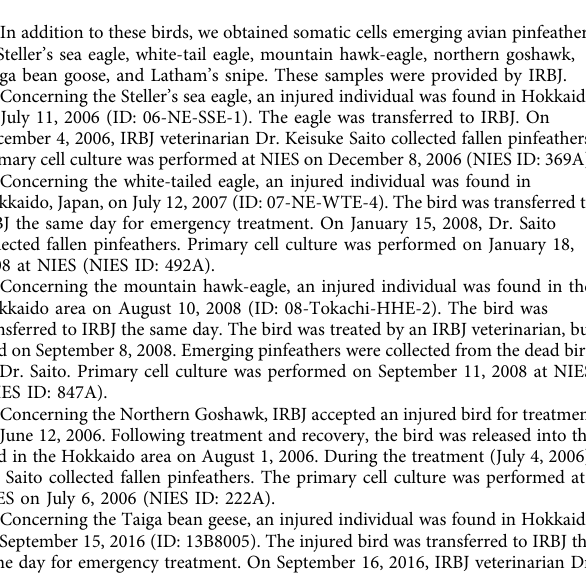
Fig. 8 Contribution of Japanese ptarmigan-derived iPSCs to chicken embryos. a iPSCs were injected into chicken blastoderm after fl uorescently labeling them with a cell tracer. b Interspeci fi c blastoderm was generated after the injection of Japanese ptarmigan-derived iPSCs into chicken blastoderm. Images shows embryos that were not injected (i – iv) and iPSC-injected blastoderm (v – viii). Panels show the merged bright fi eld and green fl uorescence images (i, v), bright fi eld images (ii, v), green fl uorescence (iii, vii), and red fl uorescence (iv, viii). Bars represent 2 mm. c The images show the contribution of iPSCs to the chicken embryo post-injection after 72 h. Arrows indicate green signals. Panels show embryos with no injection (i – iv), and iPSC-injected blastoderm (v – viii). Panels show merged bright fi eld and green fl uorescence images (i, v), bright fi elds (ii, vi), green fl uorescence (iii, vii), and red fl uorescence (iv, viii). Bars represent 2 mm. d Reaction of anti-hygromycin antibody with Japanese ptarmigan iPSCs. Staining images of the anti-hygromycin antibody with red fl uorescence-labeled secondary antibody (i – iii), staining images of the anti-hygromycin antibody with green fl uorescence-labeled secondary antibody (iv – vi). Panels show merged images (i, iv), green fl uorescence (ii, v), and red fl uorescence (iii, vi). Scale bar represents 50 μ m. e Detection of GFP, hygromycin resistance gene, and DAPI signals in embryonic cryosections on day 5. Panels show the merged image (i, v), the GFP (ii, vi), the hygromycin resistance gene (iii, vii), and the DAPI (iv, viii) stained images. Bars represent 50 μ m (upper) and 100 μ m (lower). f Detection of reprogramming vector cassette from Japanese ptarmigan-injected chicken embryos on day 5. The electrophoretic image of the detection of the reprogramming vector (PB-TAD- 7F) and the detection of the internal control (Tsc-2) shows. g , h Detection of reprogramming vector cassette from Japanese ptarmigan-injected chicken embryos on day 5 with real-time PCR. g Ampli fi cation plots of PB-TAD-7F (reprogramming vector) and Tsc-2 in chicken embryo (injection minus), Japanese ptarmigan iPSCs, and chimera No. 9 (iPSC-injected chicken embryo No. 9). h Quanti fi cation of PB-TAD-7F in iPSC-injected chicken embryos. Centerlines of box plots indicate medians; box limits indicate the 25th and 75th percentiles. n